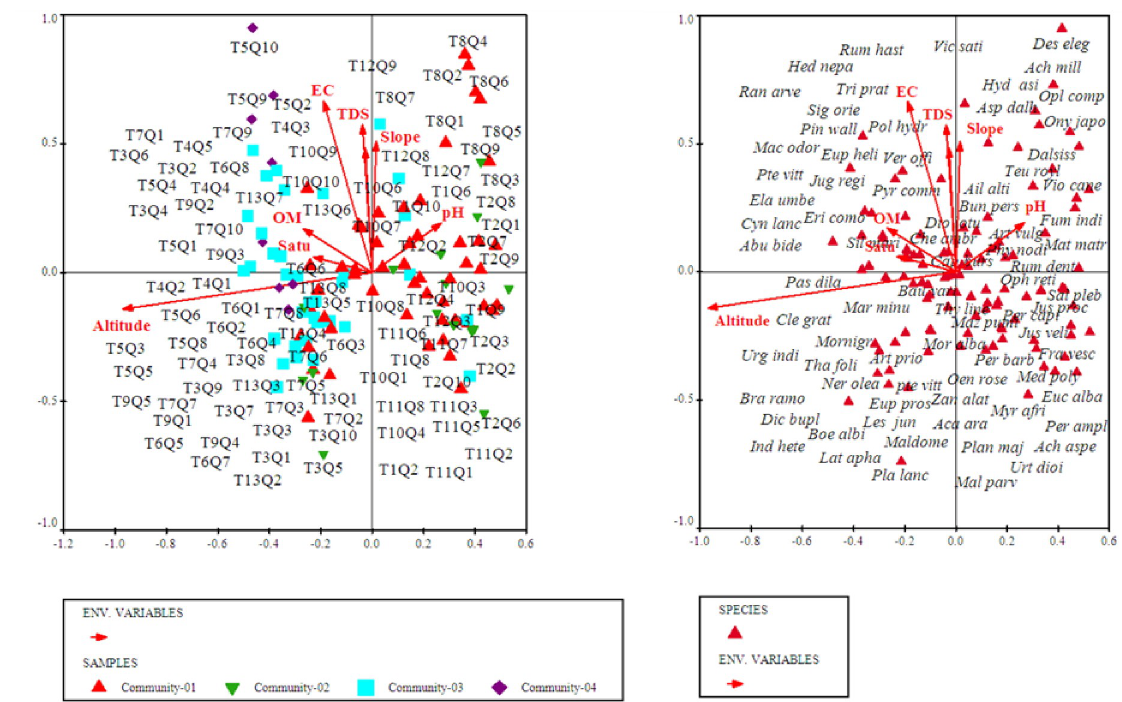
Fig 7. CCA biplots showing the distribution of plant species in relation to measured environmental factors.